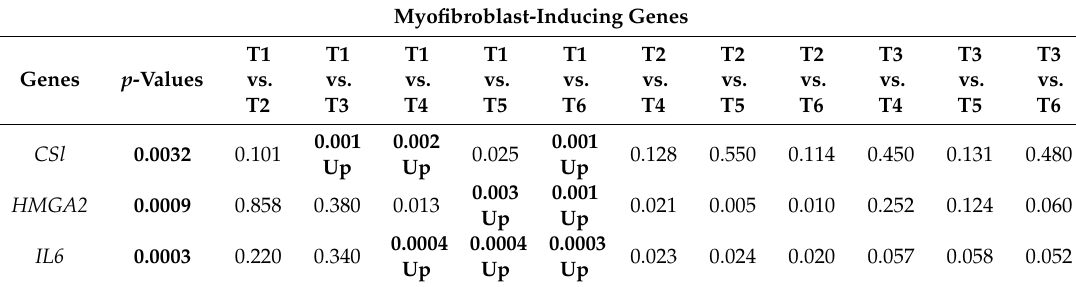
Table 3. Di ff erentially expressed genes involved in the induction of